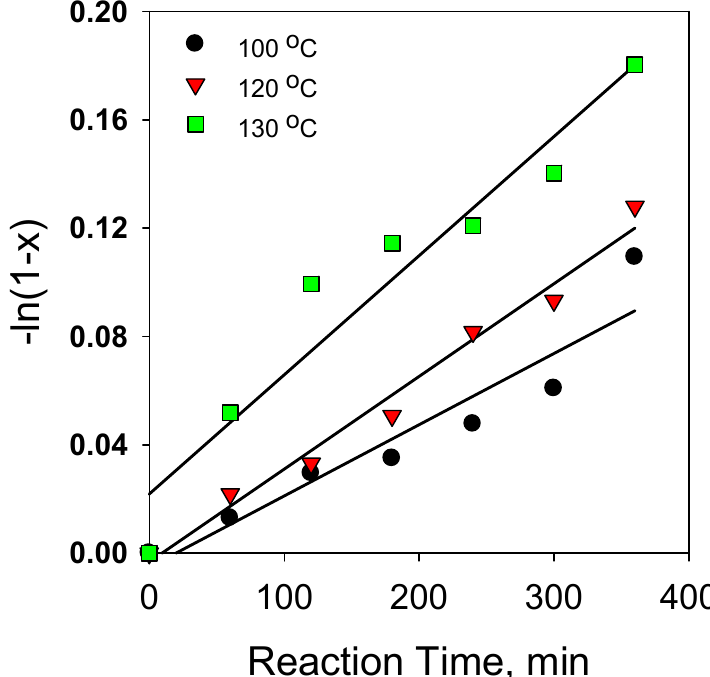
Figure 11. First-order dependence plot for hydrogenation of phenanthrene at 100 °C, 120 °C and 130 °C over 40 wt.% Ni/H β zeolite catalyst. Catalyst weight: 0.5 g; Reaction partial pressure: 2.76 MPa; volume of the reactor: 50 pressure: 6.9 MPa; H 2